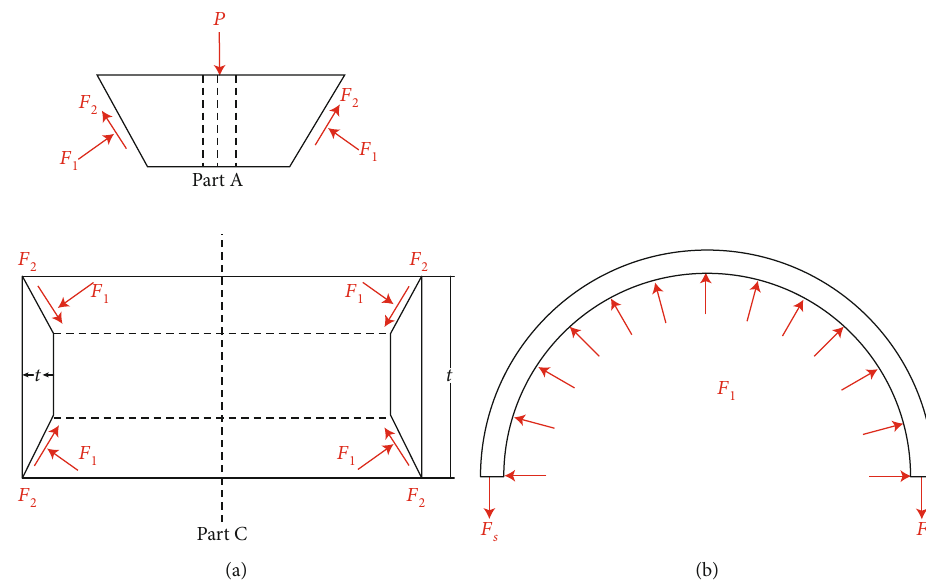
Figure 10: Force analysis of expansion test auxiliary device: (a) force analysis of front view and (b) force analysis of top